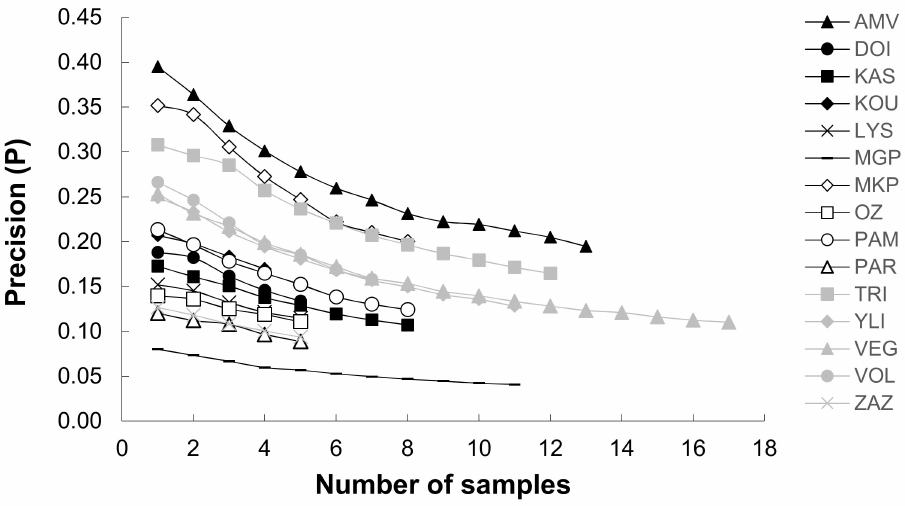
Figure 5. Average coefficient of precision estimated by bootstrapping at the sublittoral/profundal zone in accordance with the sampling